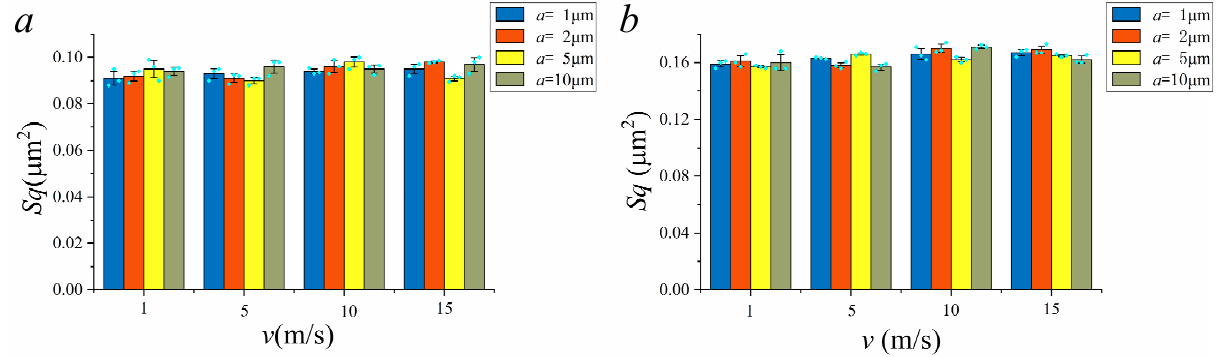
Figure 7. Comparison results of Sq . ( a ) Sq of HFB; ( b ) Sq of LFB.